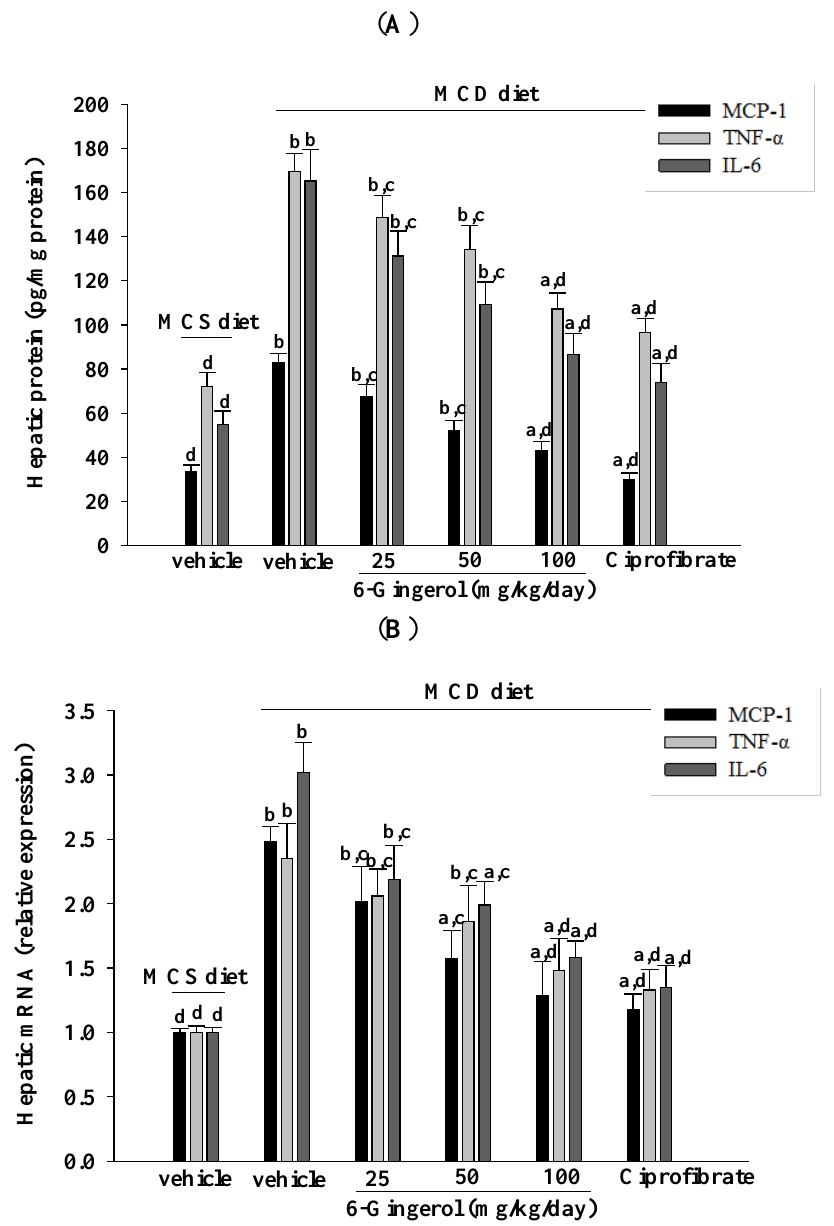
Figure 5. Effects of different treatments on inflammatory cytokines in mice. ( A ) Protein and ( B ) mRNA levels of MCP-1, TNFα and IL-6 in the livers of MCS diet- and MCD diet-fed mice after four weeks of treatment. MCD diet-fed mice were administered 25, 50, or 100 mg/kg/day of 6-gingerol or 10 mg/kg/day of ciprofibrate (ciprofibrate) by oral gavage once daily for four weeks. Another group of animals were administered the same volume of vehicle (distilled water) used to prepare the test medication solutions. The results are means ± SD for eight mice/group after four weeks of treatment. a p < 0.05 and b p < 0.01 compared to the values of vehicle-treated MCS-diet fed mice. c p < 0.05 and d p < 0.01 compared to the values of vehicle-treated MCD-diet fed